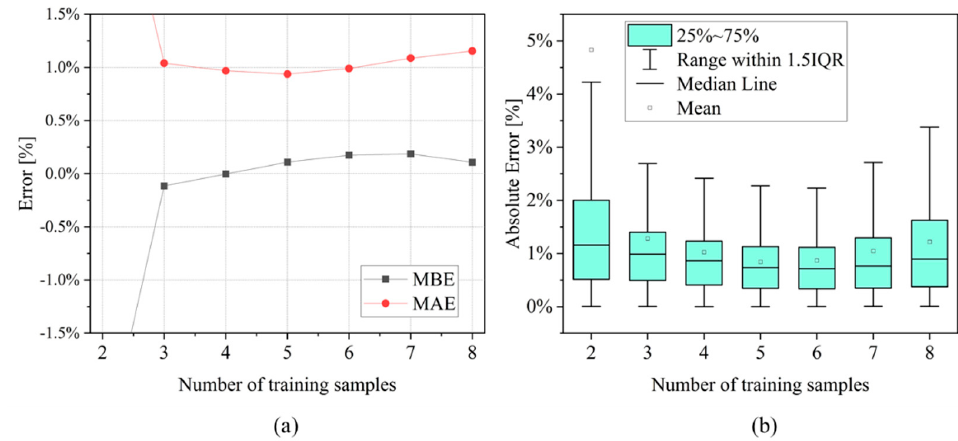
Figure 12. Analysis of all the possible combinations of training sets with a number of cells between 2 and 8: ( a ) MBE and MAE results over the whole SoH range; and ( b ) box plot results in the SoH range